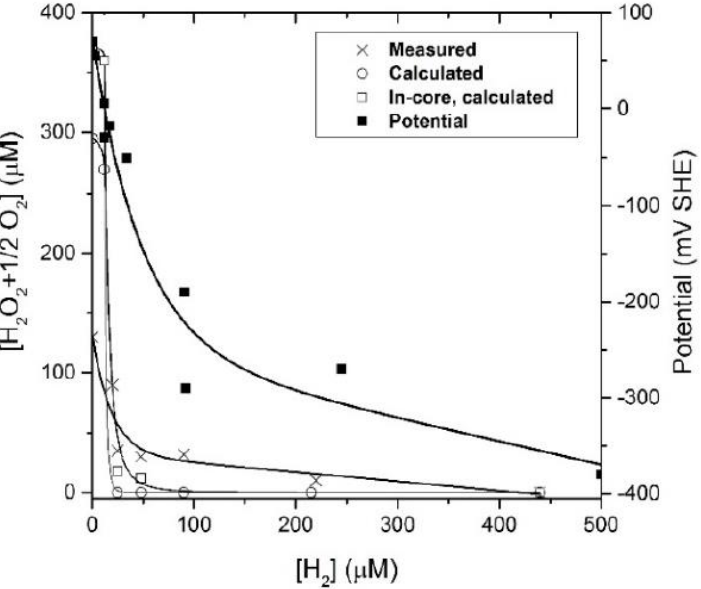
Figure 26. Oxidant concentration and the ECP of stainless steel at 50 °C, as a function of inlet hydrogen concentration as measured in Studsvik’s INCA in-reactor loop (after Christensen et.al. [28]). © 1996 ITER Organization. This image is hereby used courtesy of the ITER Organization.